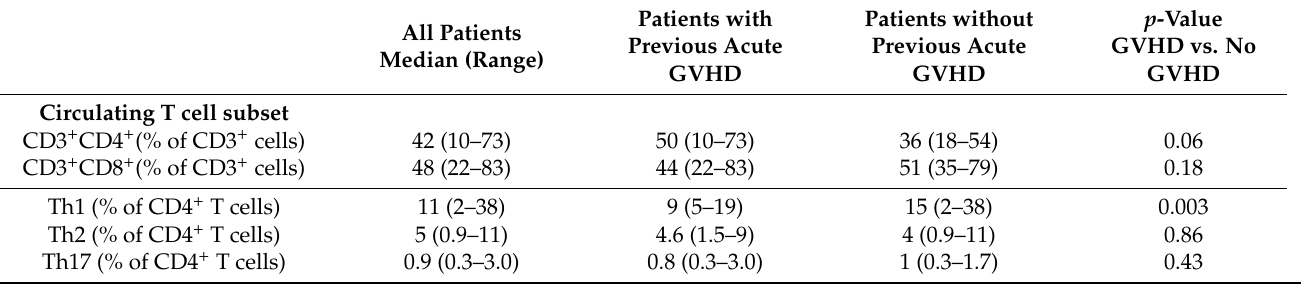
Table 5. Levels of circulating T cell subsets in allotransplant recipients. We investigated 24 patients and present the results for all patients and patients with/without previous acute GVHD. Different groups were compared using the Mann–Whitney-U test. IL-6R expression is presented as the mean fluorescence